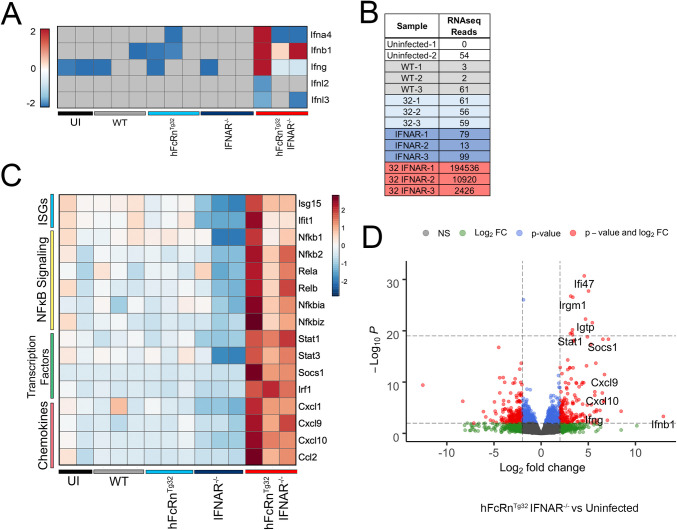
Transcriptional profiling from the livers of E11 infected hFcRnTg32-IFNAR-/- animals reveals induction of a proinflammatory immune response to infection.RNAseq-based transcriptional profiling from RNA isolated from the livers of E11 infected C57Bl/6 (WT), hFcRnTg32, IFNAR-/- or hFcRnTg32-IFNAR-/- animals (3 animals each), or uninfected controls (2 animals) was performed. (A) Heatmap of log2RPKM values for type I (Ifna4, Ifnb1), II (Ifng), and III (Ifnl2, Ifnl3) IFNs in the livers of the indicated genotypes 72hpi. Scale shown at left. (B) RPKM values mapped to the E11 genomic sequence in each genotype. Individual animals are shown. (C) Heatmap based on log2RPKM values of select proinflammatory cytokines in the livers of following E11 infection of the indicated genotypes, or uninfected controls. Scale is shown at right. In (A) and (C), red indicates higher expression and blue indicates lower expression. Gray denotes no reads detected. (D) Volcano plot of differentially regulated genes in hFcRnTg32-IFNAR-/- adult animals compared to uninfected animals. Red indicates genes with a statistically significant upregulation or downregulation of > or < log2 fold-change of 2 and p<0.05.